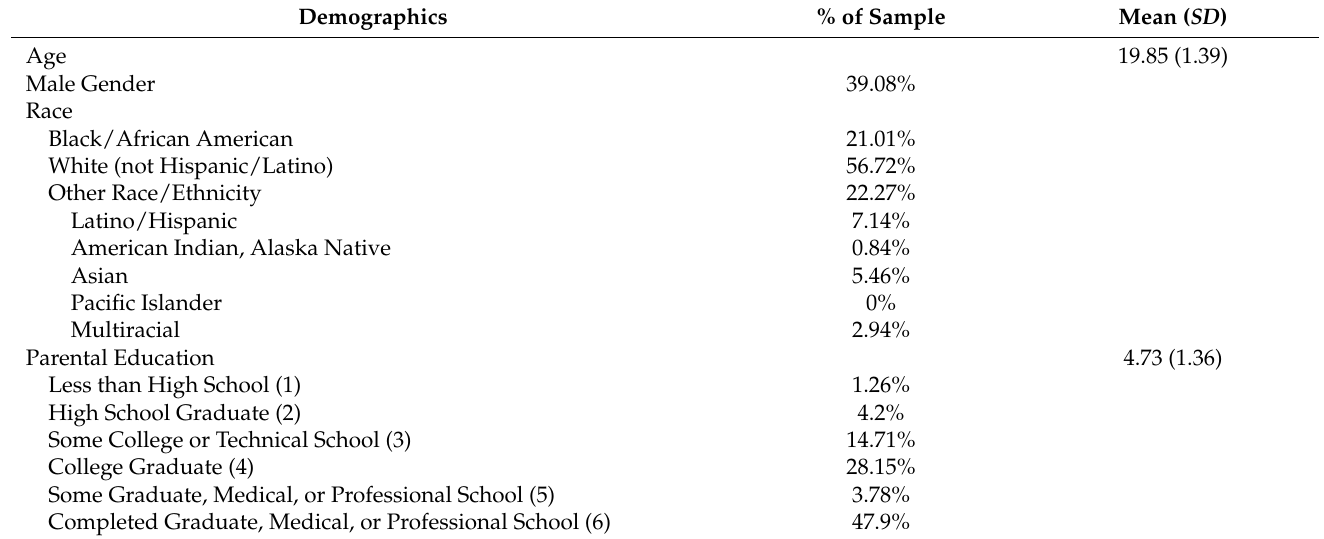
Table 1. Sample Characteristics of Parent-Emerging Adult Dyad Text Message Sample ( N =